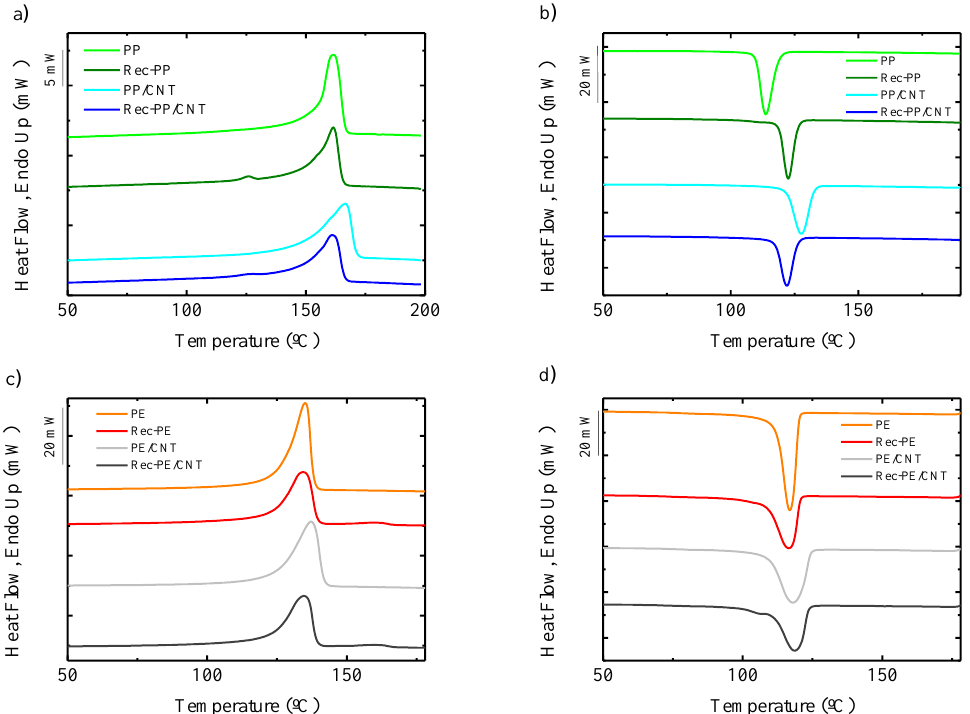
Figure 2. DSC heating and cooling scans of all the samples studied in this work: ( a ) heating and ( b ) cooling scans of PP based samples, ( c ) heating and ( d ) cooling scans of PE based materials.